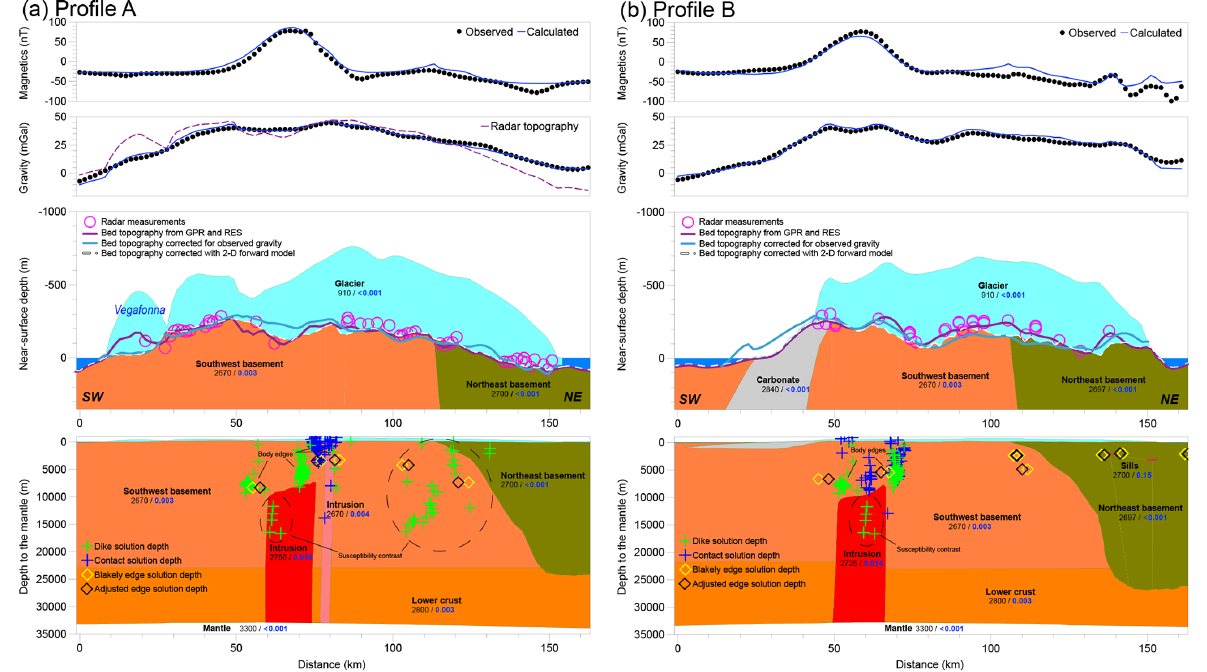
Figure 5. Observed and calculated magnetic and gravity profiles (top), the near-surface view of the basements (middle) and the depth to the mantle (bottom) for profile A (a) and profile B (b) , as defined in Fig. 2, with Werner deconvolution indicators of the intrusions and the basement interfaces. A gravity response (purple solid lines) is calculated for a homogeneous bedrock using GPR–RES bed topography. The misfit with the observed gravity measurements suggests the bedrock is heterogeneous and the bed topography from the radar needs refining. The gravity-corrected bed topography (blue lines in the near-surface view panel) is an improvement but fails to recognize the heterogeneity of the bed. The 2-D forward model (dashed white line) improves the accuracy of the bed topography by using a density more representative of the lithology. Each section representing a geological body is characterized with a density (kgm − 3 ; black values) and a susceptibility (SI units; blue values). Dike solution depths (green crosses), contact solution depths (blue crosses), Blakely edge solution depths (yellow diamonds) and adjusted-edge solution depths (black diamonds) are